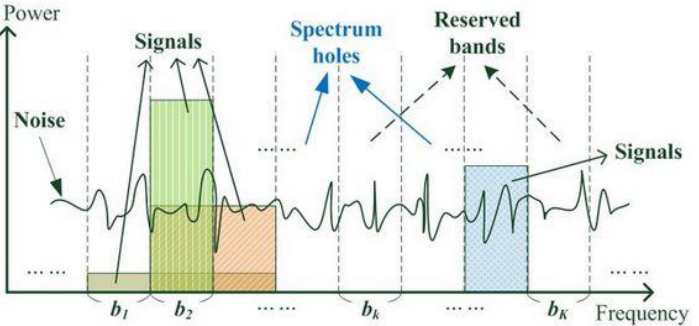
Figure 1. Spectrum model depicting signals, noise, reversed bands, and the spectrum holes in k bands [6].